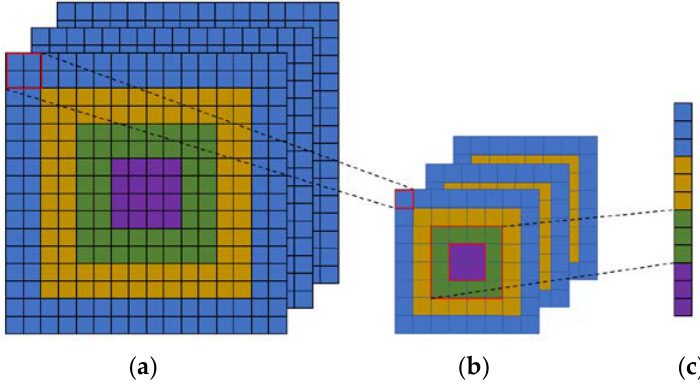
Figure 5. An example four-level concentric circle pooling. ( a ) The output feature map of last convolutional layer; ( b ) The results after sliding window pooling which transforms each circle in output feature map of last convolutional layer to one-pixel width; ( c ) The outputs of concentric circle pooling which computes the maximum or mean of each annular subregion for each channel and concatenates them.